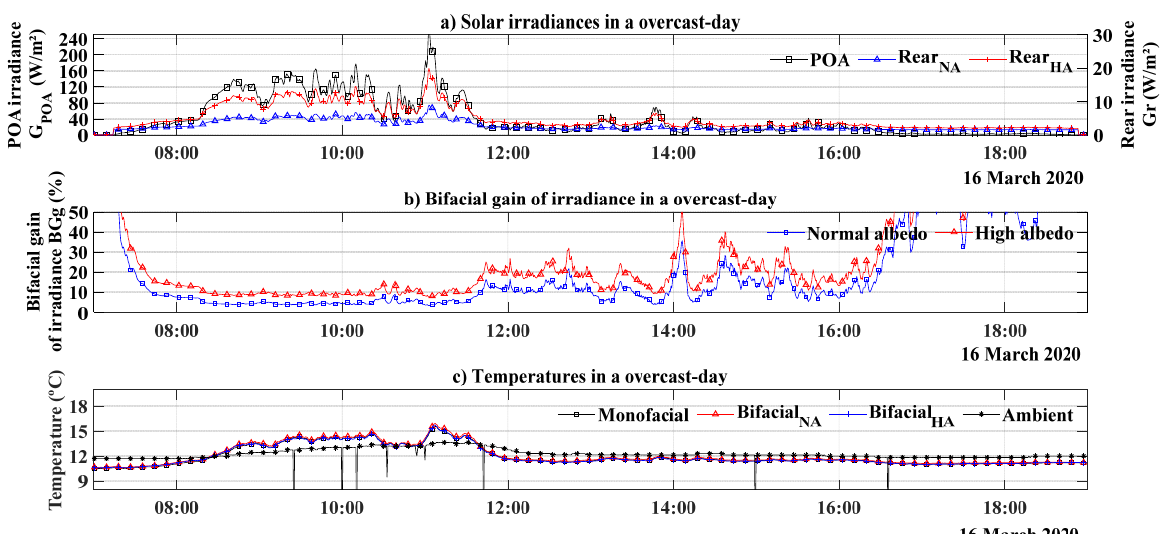
Figure 6. Measured weather parameters under overcast sky; ( a ) Front and rear solar irradiance. ( b ) Bifacial gain for normal and high albedos. ( c ) Operating and ambient temperatures.